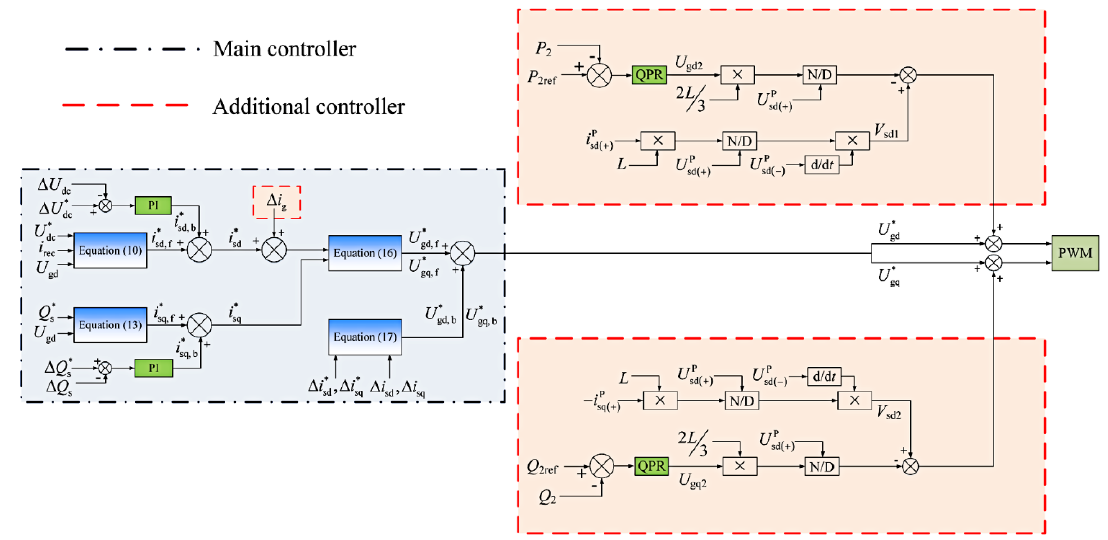
Figure 5. Overall diagram of PMSG grid-side VSC improved control schemes.